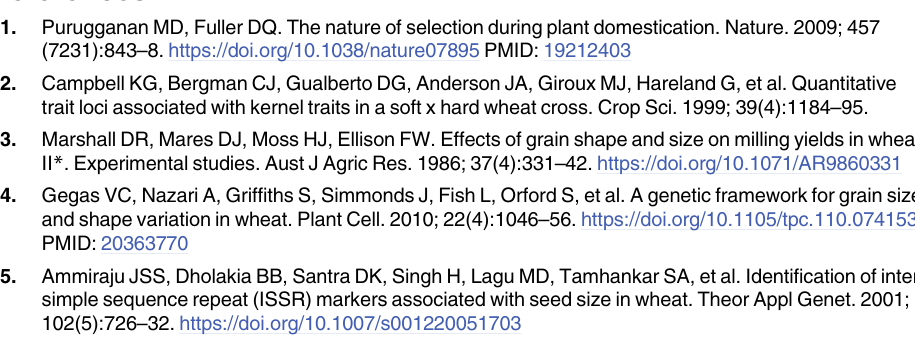
S1 Fig. Interval mapping LOD scans for flour yield (Fyd) and time to maturity (Mat) on linkage group 7D.2. Mat data was described previously [27]. S1 Table. The RL4452/’AC Domain’ linkage map constructed with 193 DH lines tested with 12,202 DNA markers (11,283 SNPs and 919 PCR-based markers). S2 Table. Descriptive statistics and heritability estimates of the traits evaluated on the RL4452/’AC Domain’ DH population. S3 Table. Correlation analysis of agronomic, milling, and seed shape traits in the RL4452/ ‘AC Domain’ DH population. S4 Table. Digenic epistatic QTL identified in the RL4452/‘AC Domain’ DH population by Inclusive Composite Interval Mapping (QICE module) for agronomic, milling, and seed shape